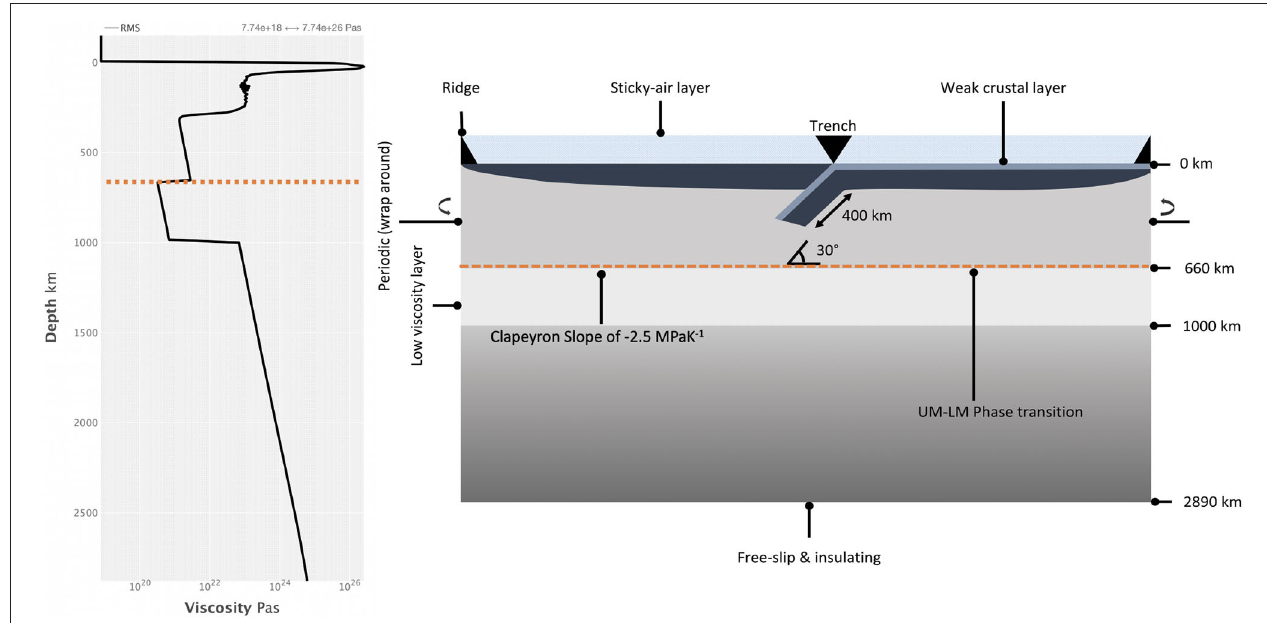
FIGURE 3 | Schematic showing a 1-D root-mean-square, horizontally averaged viscosity profile of our model on the left. The high viscosity at the top-most upper mantle is the result of the high viscosity of the initial slab, which adds to the average viscosity at this depth and overprints the viscosity of the asthenosphere that is present in all our models. The minimum and maximum values of the viscosity are included at the top right of the RMS profile. On the right we show our model setup where changes in the background viscosity follow from Equations (7)–(9). Viscosity increases are indicated by darker shades of